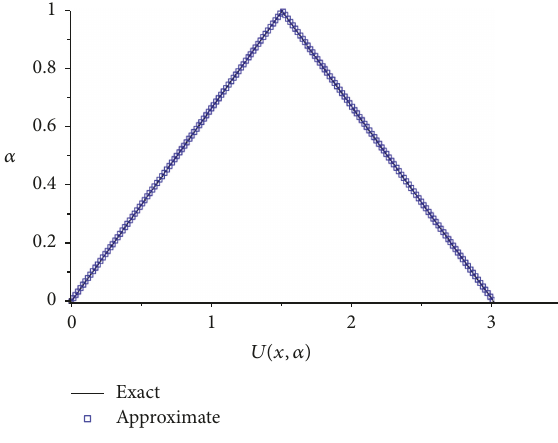
Figure 1: Exact and numerical solutions at 𝑥 = 𝜋/8 .